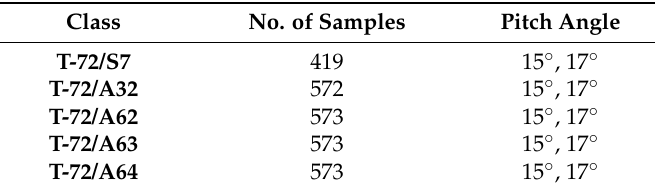
Table 6. Test set under EOC2 (configuration variant).